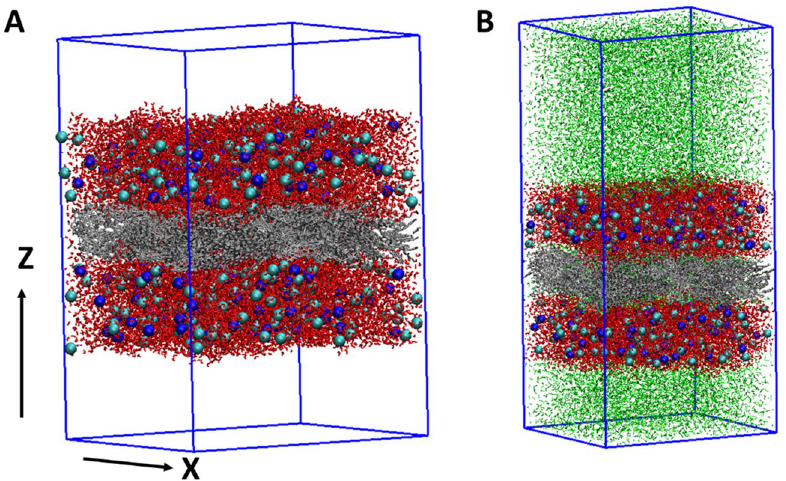
Figure 1. Simulation snapshots illustrating IID-CuCl 2 ( A ) and IID-CuCl 2 -CO 2 ( B ) model systems (see Table 1). Color codes: kerogen—silver, water—red, Cu 2+ —blue, Cl − —cyan, and CO 2 —green. Simulation box size and number of molecules simulated for each system are reported in Table 1. Some water and CO 2 molecules can adsorb deeply inside the kerogen porous structure. However, no ion is observed inside the structure due to small pore